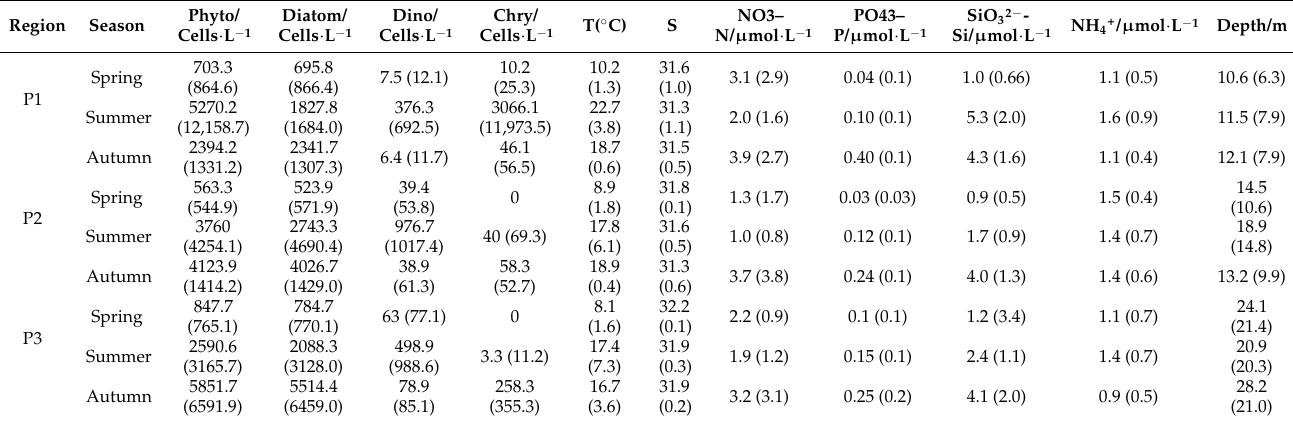
Table 5. Phytoplankton abundance (cells · L − 1 ) (means, SD in parentheses) and environmental parameters in the different ecological assemblages during three cruises (spring, summer and fall) in the BS and NYS. (Phyto: phytoplankton, Dino: dinoflagellates, Chry: Chrysophyta, T: temperature, S: